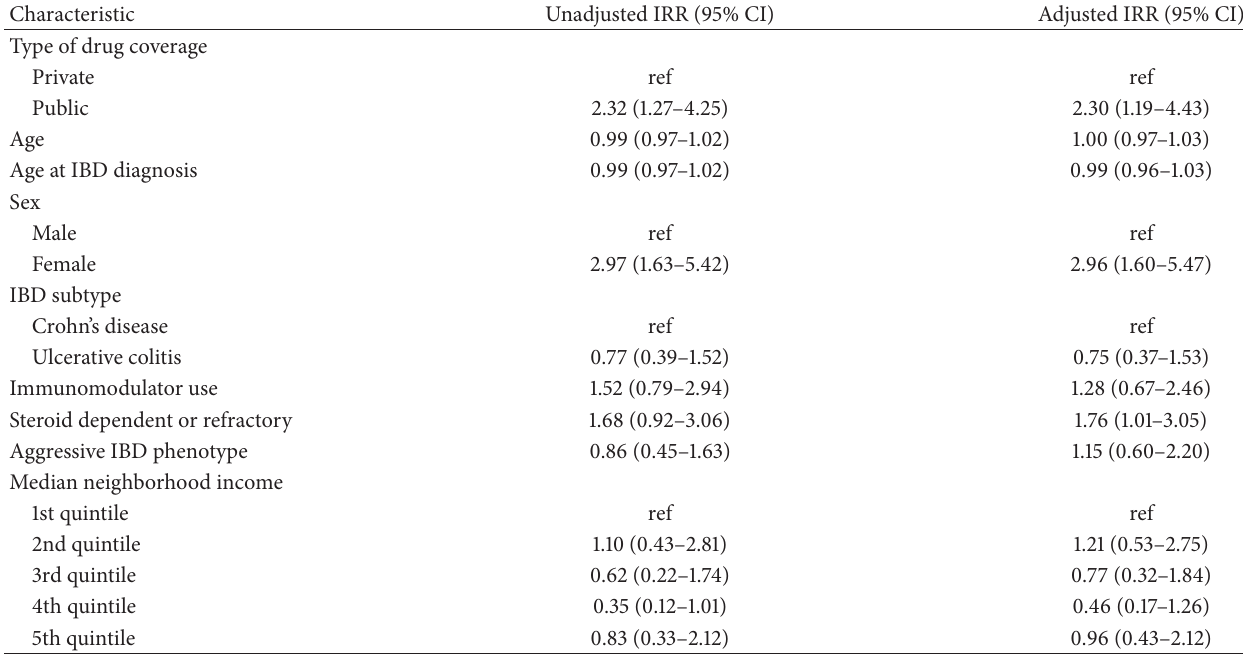
Table 4: Poisson regression model for IBD-related admissions.